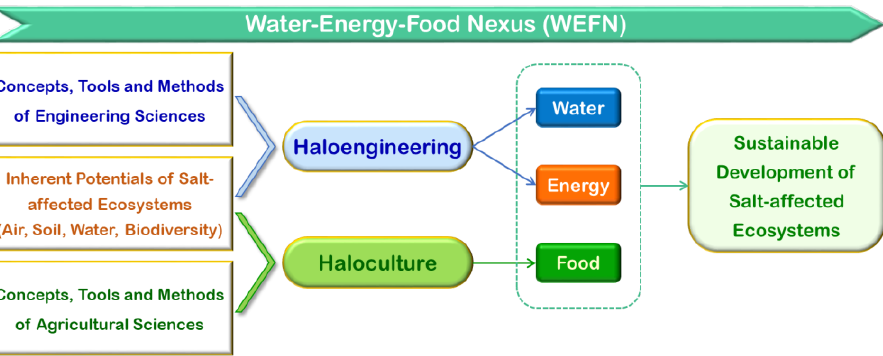
Figure 2. The principles of Haloengineering and Haloculture under the concept of WEFN.